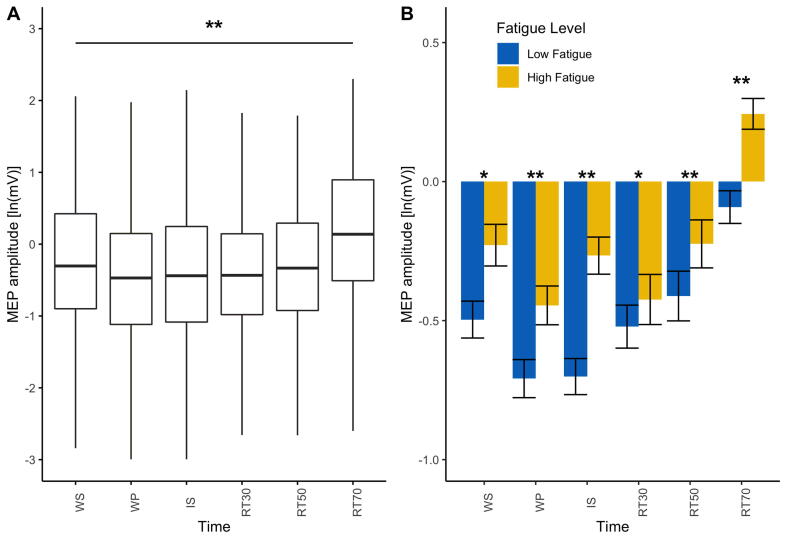
The effect of time and fatigue on motor evoked potential (MEP) amplitude. A. Boxplot for MEP amplitude across all stroke survivors for each time point indicating the significant effect of time on MEP amplitude. B. Bar plots with standard error bars representing MEP amplitude across all time points with stroke survivors grouped based on their fatigue score indicating the significant interaction between time2 and fatigue on MEP amplitude. Fatigue was measured using the Fatigue Severity Scale (FSS-7). Low fatigue patients (FSS-7 < 4) are represented in blue and high fatigue patients (FSS > 4) are represented in yellow. The association between fatigue (FSS-7) and MEP amplitude for each time point is also shown. Significance levels are indicated by * (* < 0.05, ** < 0.001).